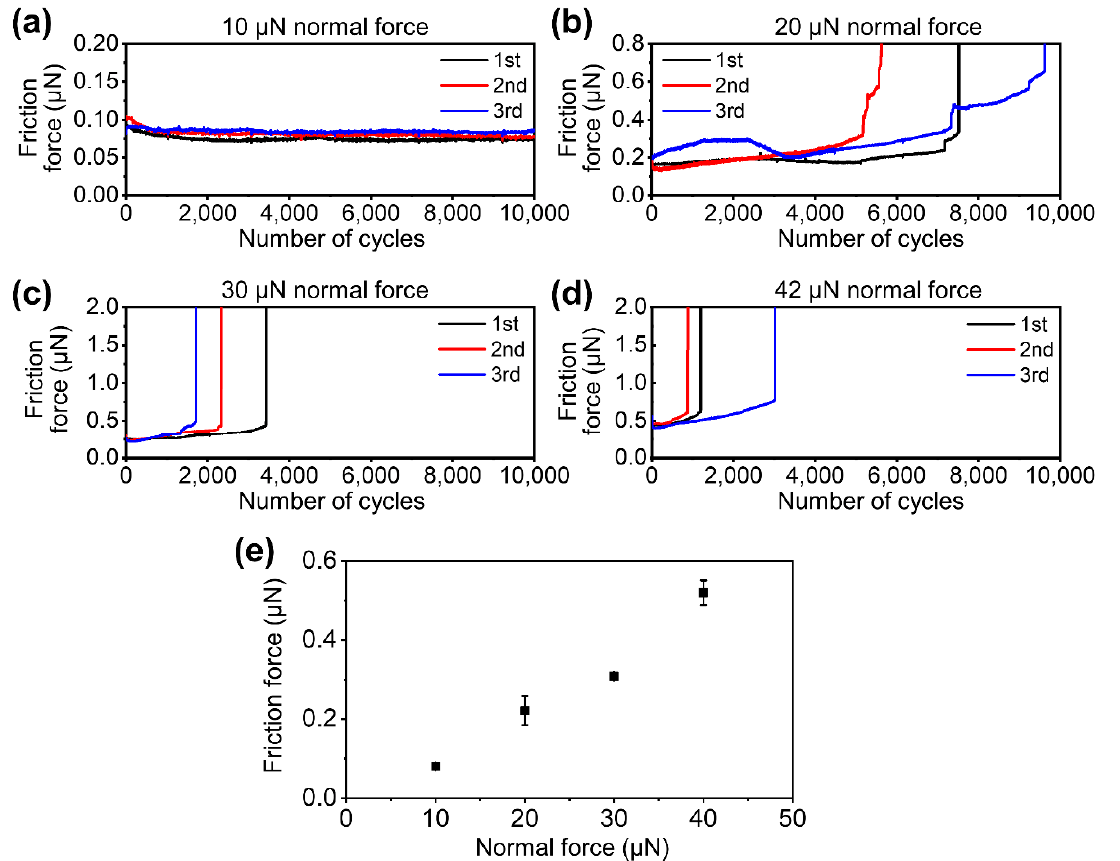
Figure 2. Variations of friction forces between 1L h-BN and the colloidal probe with respect to the number of cycles under ( a ) 10 µ N, ( b ) 20 µ N, ( c ) 30 µ N, and ( d ) 42 µ N normal forces as well as ( e ) the plot of the friction force before the failure of 1L h-BN as a function of the normal force.